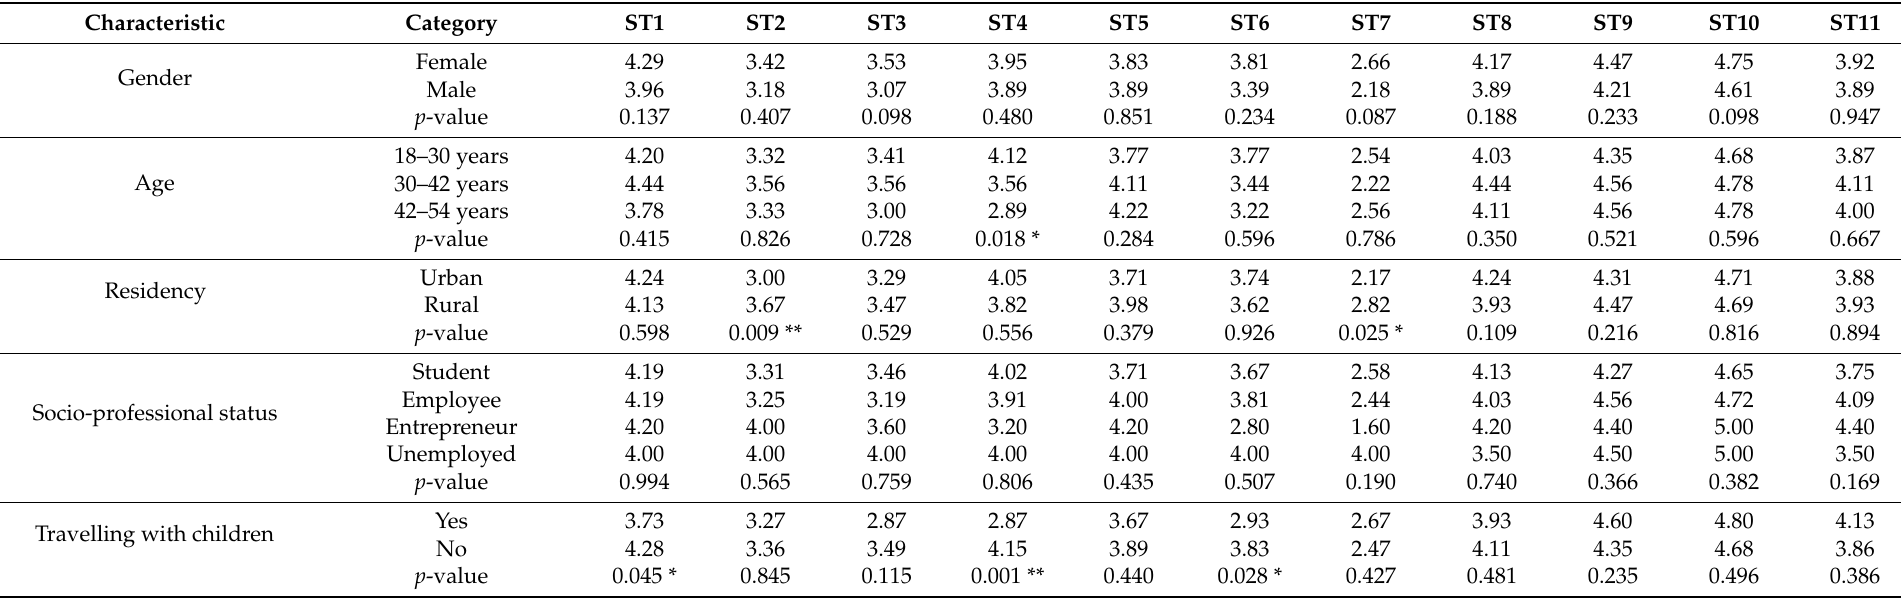
Table 5. Results of the Mann–Whitney U test and the Kruskal–Wallis test of socio-demographic characteristics and attraction